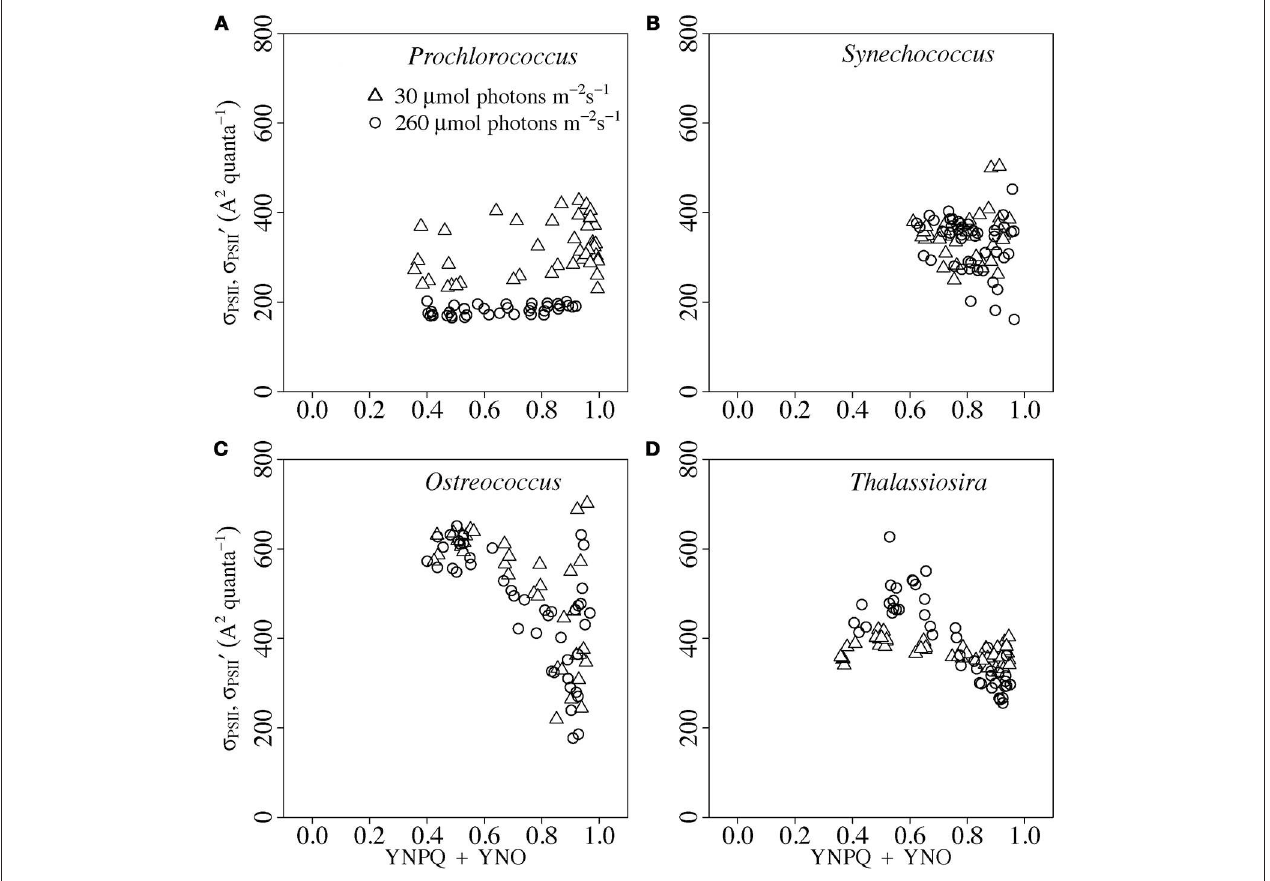
FIGURE 5 | σ PSII ′ vs. YNO plus YNPQ in Prochlorococcus (A) , Synechococcus (B) , Ostreococcus (C) , or Thalassiosira (D) from growth-limiting (open triangles) or growth saturating light (open circles). Induction of YNO and YNPQ was driven by increasing actinic light ( Figure 1A ). Paired determinations from 4 to 8 replicate cultures plotted